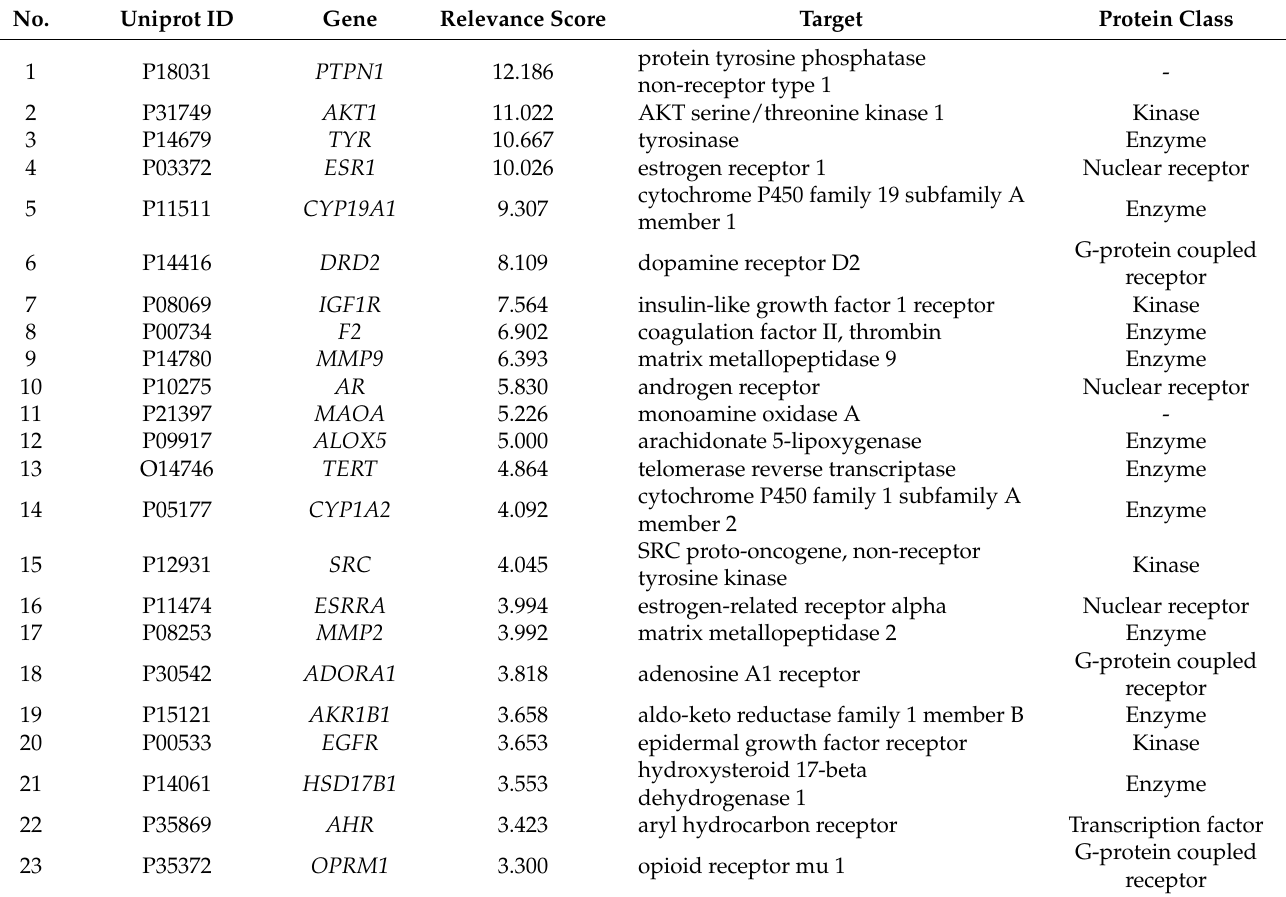
Table 2. Potential targets of p